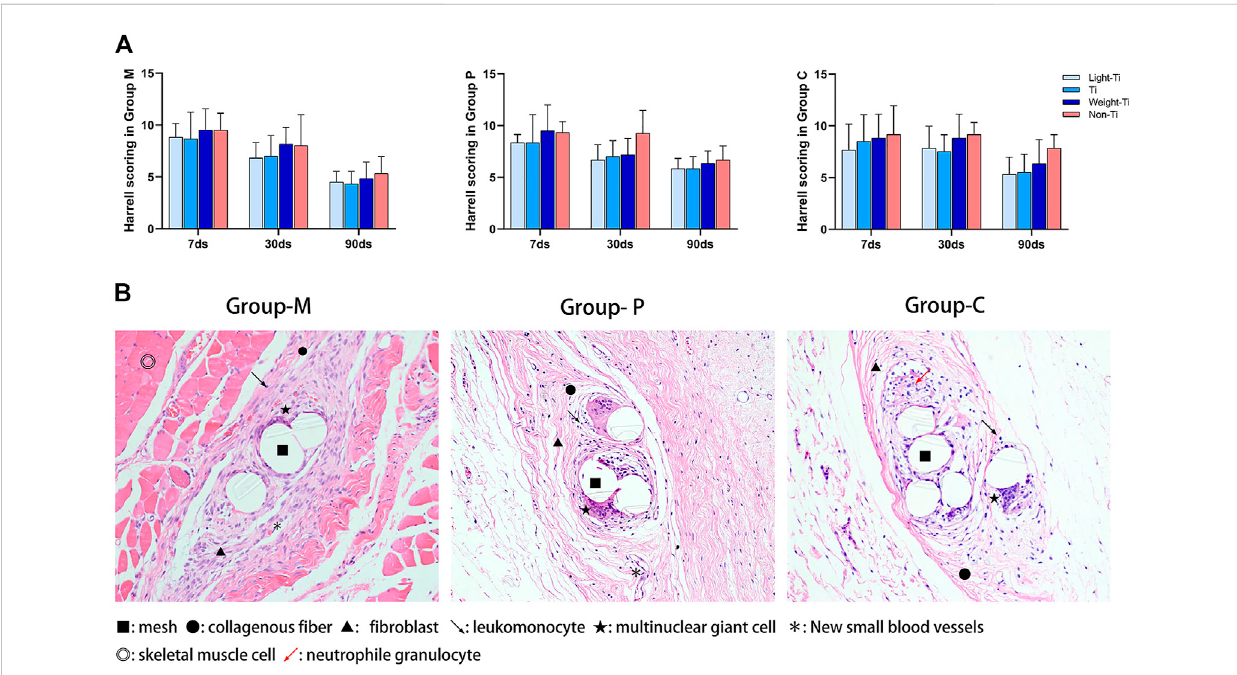
HE staining and its Harrell Scoring scale results. (A) Harrell Scoring scale results of different parts were obtained according to HE staining; (B) The situation of the mesh and the surrounding tissue between the external oblique abdominal muscle and the internal oblique abdominal muscle, on the parietal peritoneum, and on the wall of the descending colon. (HE staining, ×100 magni fi